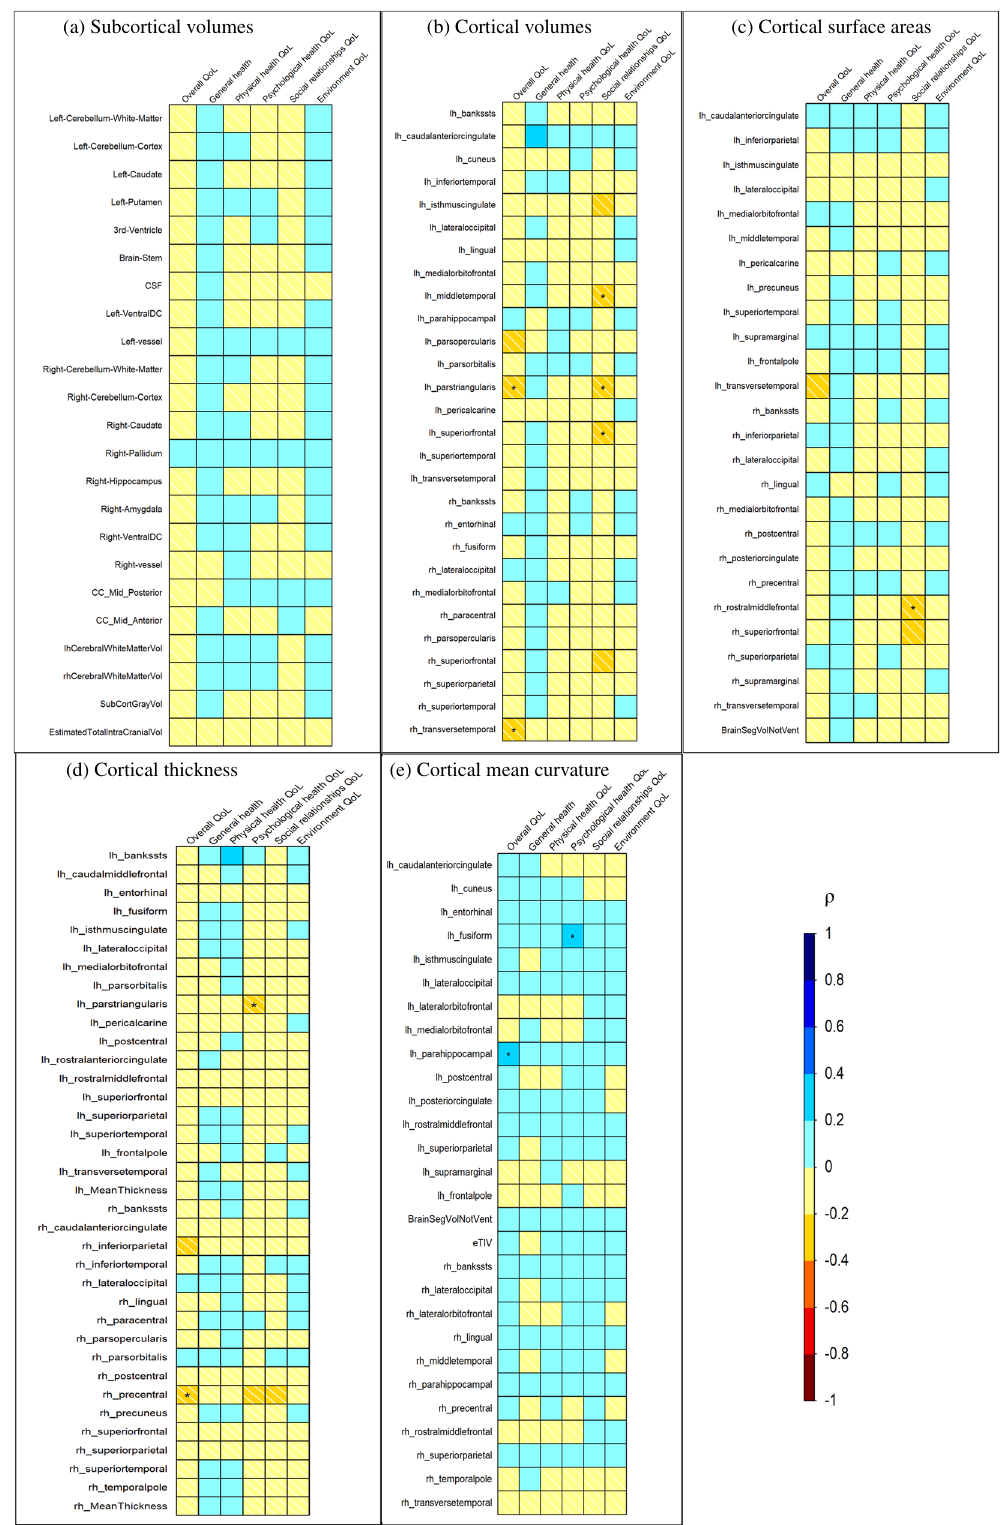
Figure 5. Spearman’s rank-order correlation of the ΔQoL items and ΔFeatures, with feature sets from studies 1–5 i.e., ( a ) subcortical volumes, ( b ) cortical volumes, ( c ) cortical surface areas, ( d ) cortical thickness and ( e ) cortical mean curvature (*p-value <